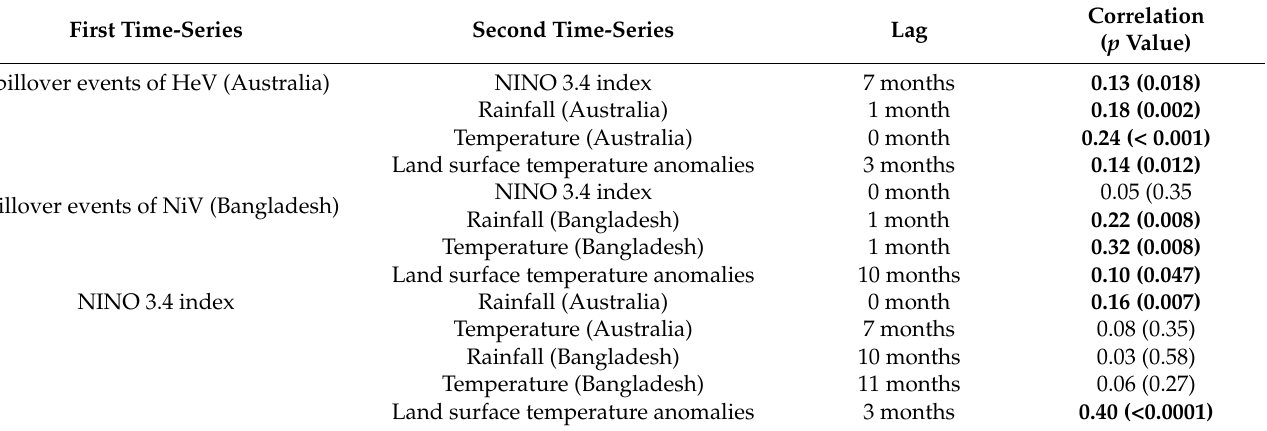
Table 4. Results of temporal cross-association between spillover events of the Hendra virus (HeV), the Nipah virus (NiV), NINO 3.4 index, the average monthly temperature in Australia and Bangladesh, the average monthly rainfall in Australia and Bangladesh, and land surface temperature anomalies (monthly lag values were obtained from time-series cross-correlation analysis). Significant correlations are highlighted in bold.